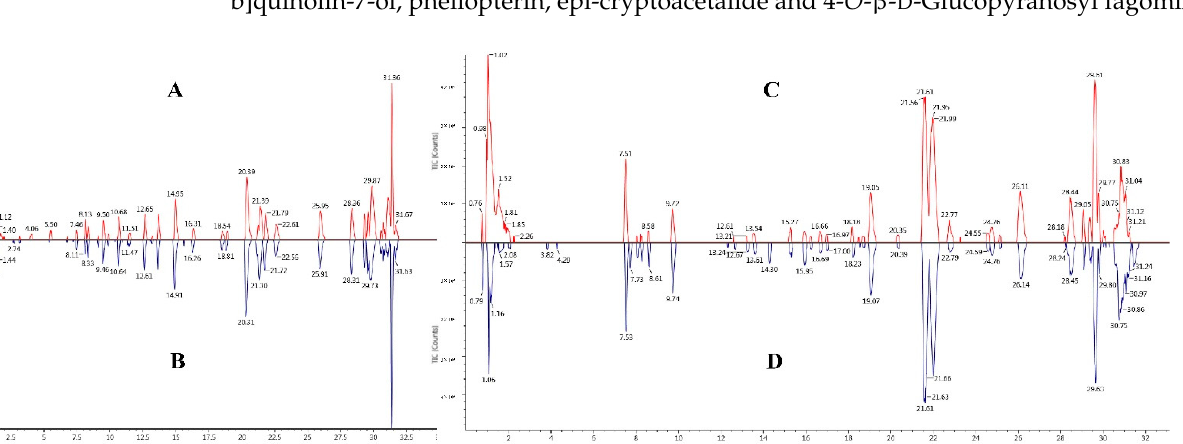
Figure 1. Typical total ion chromatogram (TIC) of SHLE before fermentation (( A ): positive ion mode; ( C ): negative ion mode) and SHLE after fermentation (( B ): positive ion mode; ( D ): negative ion mode). 3.2. The Growth of L. fermentum grx08 in SHLE L. fermentum grx08 had good growth characteristics in SHLE (Figure 2). After 72 h of fermentation, the lg (CFU/mL) value of living bacteria increased from 7.69 to 8.78, the pH value decreased from 5.01 to 4.00 and the titration acidity increased from 7.42 °T to 53.30 °T. After 18 h of fermentation, the pH value remained basically unchanged but the titra- tion acidity continued to increase and tended to be stable at 72 h.